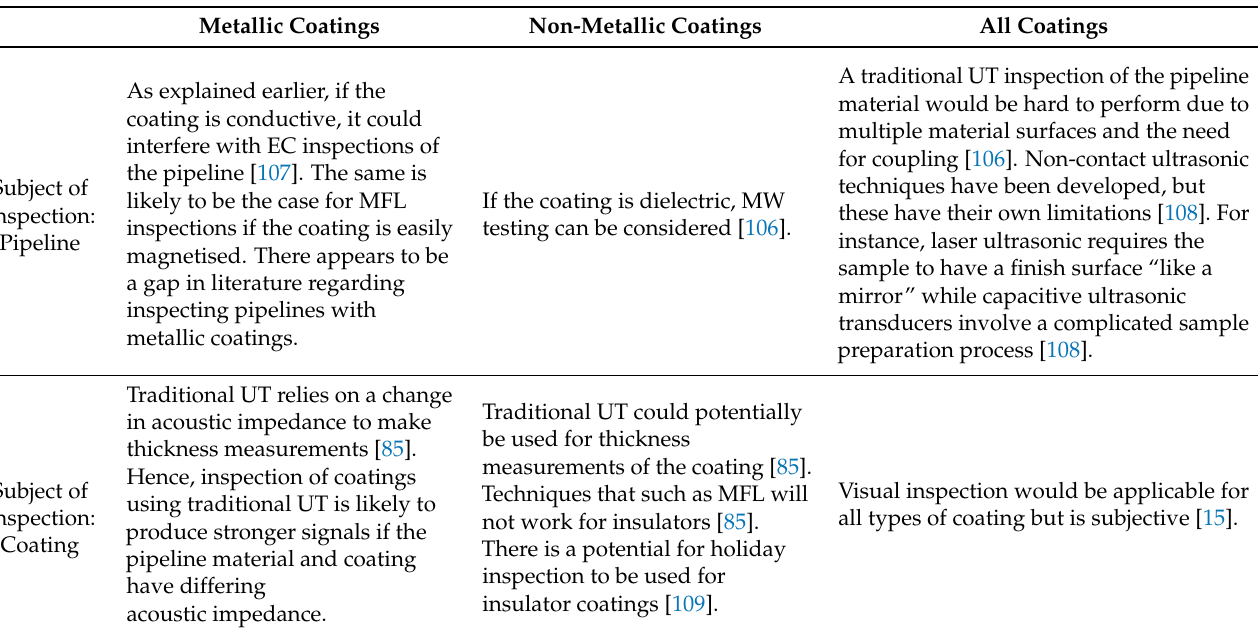
Table 10. A summary of how NDT method choice is affected by coating type when the subject of inspection